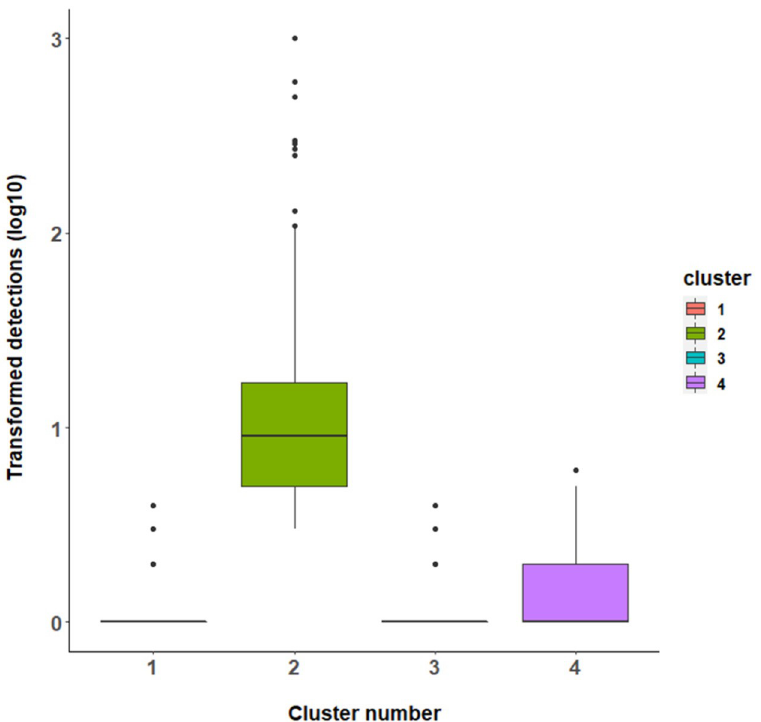
Fig 6. Cluster profile using a boxplot for log10 transformed detection frequency for the four-component cluster model utilizing both numerical and categorical variables for data from Barrow Island from 2009 to 2015.